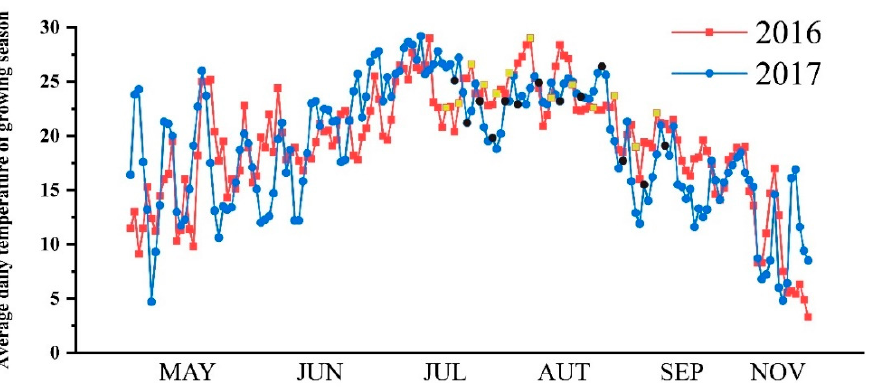
Figure 6. Average daily temperature (°C) of growing season in experimental site. The sampling dates were marked yellow squares (2016) and black circles (2017).